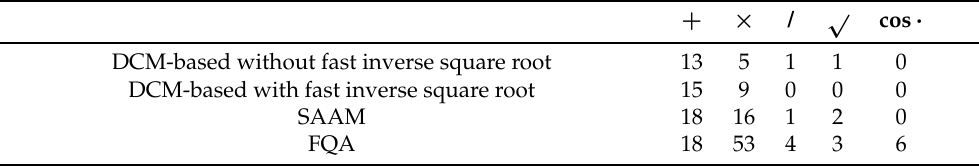
Table 1. Comparison of calculation cost of q rs (results of SAAM and FQA are cited from [42]). √ + × / cos · DCM-based without fast inverse square root 13 5 1 1 0 DCM-based with fast inverse square root 15 9 0 0 0 SAAM 18 16 1 2 0 FQA 18 53 4 3